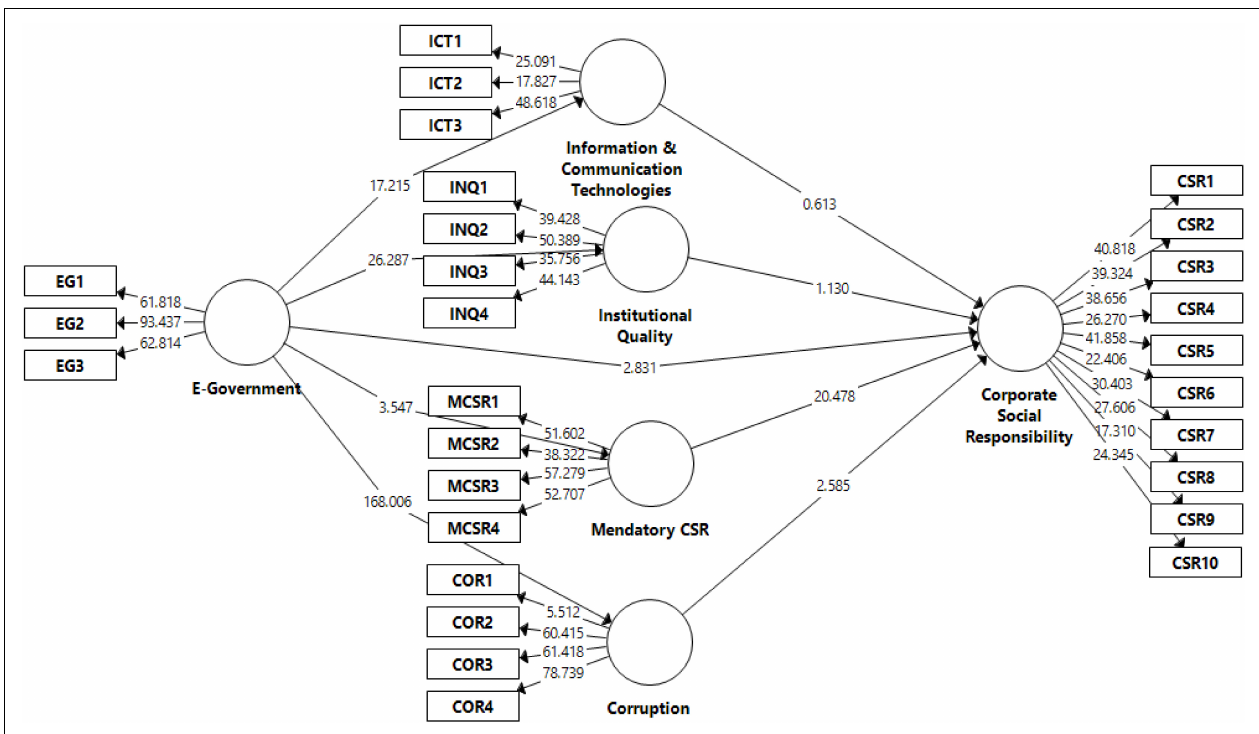
FIGURE 3 | Partial least square-bootstrapping for the structural